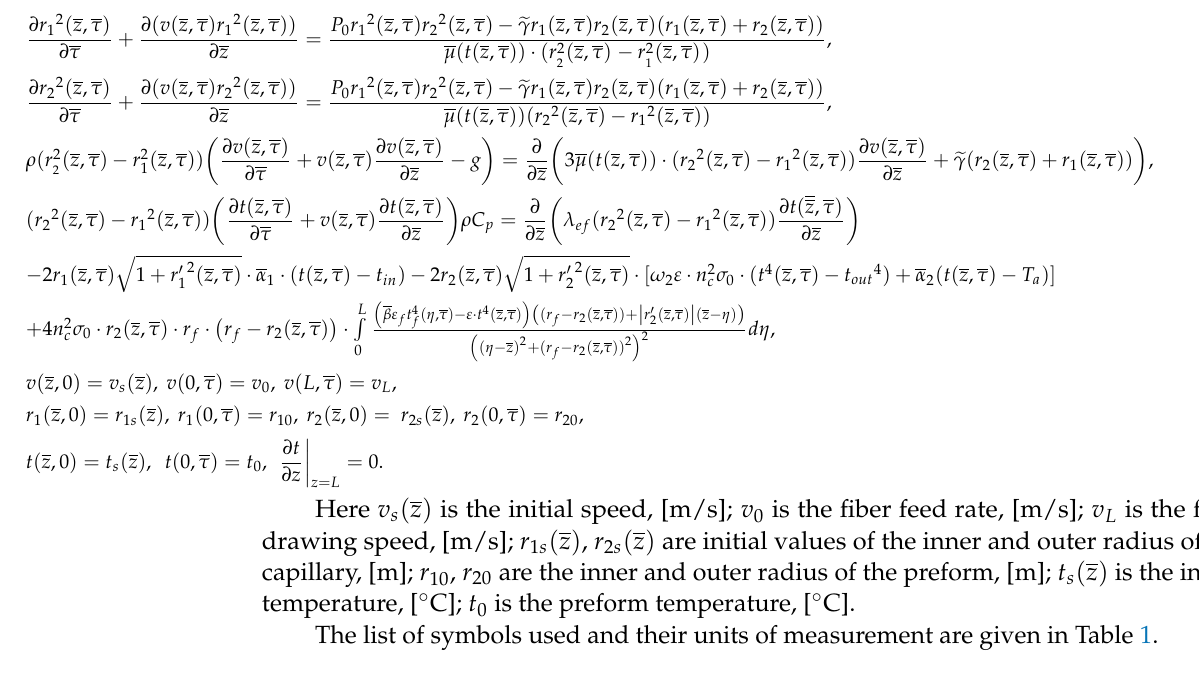
Table 1. Symbols used and their units of